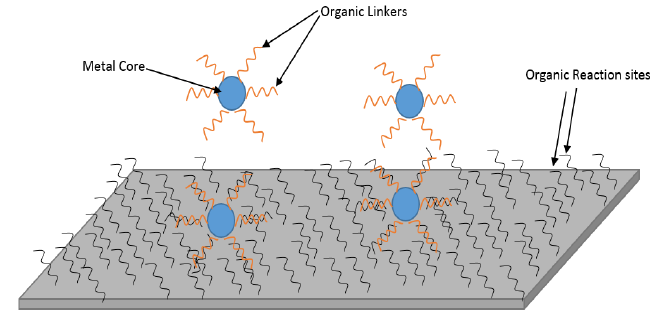
Figure 10. MOFs filling into polymeric substance diagram.